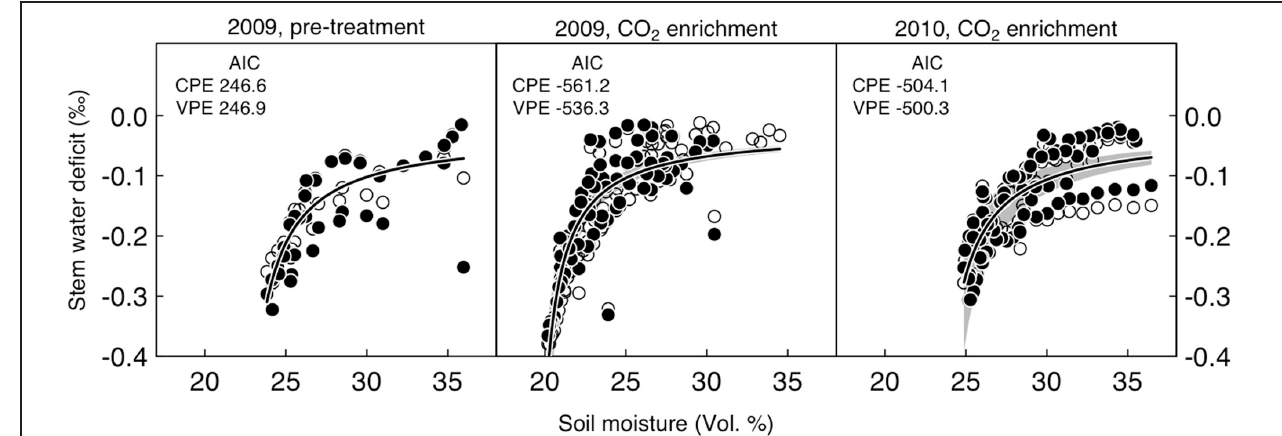
FIGURE 4 | Relationship between soil moisture (mean across ambient and CO 2 -treated area) and stem water deficit in per mille for P. abies under ambient (open symbols) and elevated CO 2 -conditions (filled symbols). Periods between day of year 175 and 250 were considered. AIC, Akaike Information Criterion; CPE, nonlinear model with common parameter